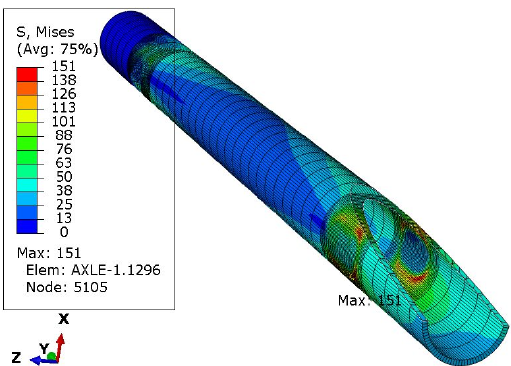
Figure 6. HMH stress distribution in the axle while only left wheel loaded with F 1side force. Trail front in Z direction.